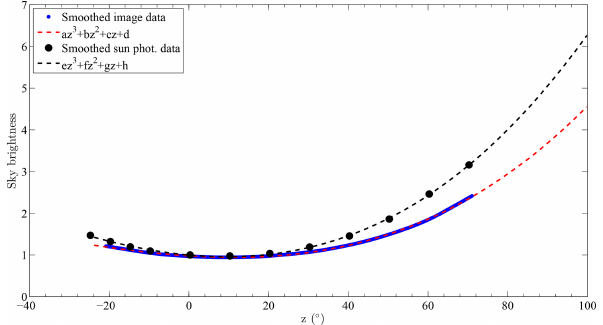
Figure 8. All-sky camera and sun photometer normalized fitting polynomials (black dashed line – sun photometer, red dashed line – camera).